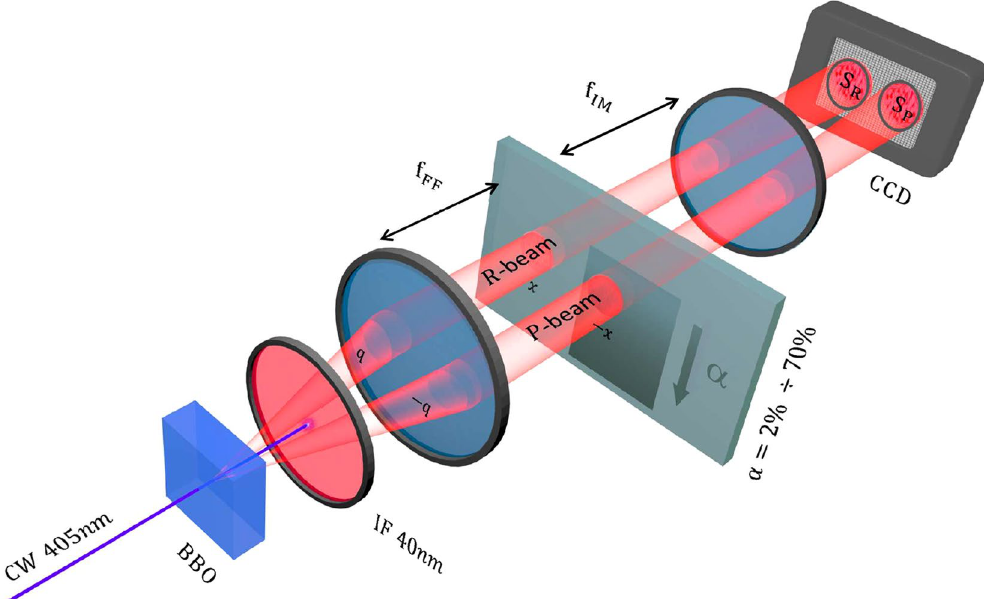
Figure 2. Scheme of our experimental set-up. In the BBO crystal two beams with perfect correlation in the photon number (TWB state) are generated. The probe beam passes trought the sample and is then detected in the S P region of the CCD, on the contrary the reference beam goes directly to S R , without interacting with the sample. A detailed description of the optical components can be found in the